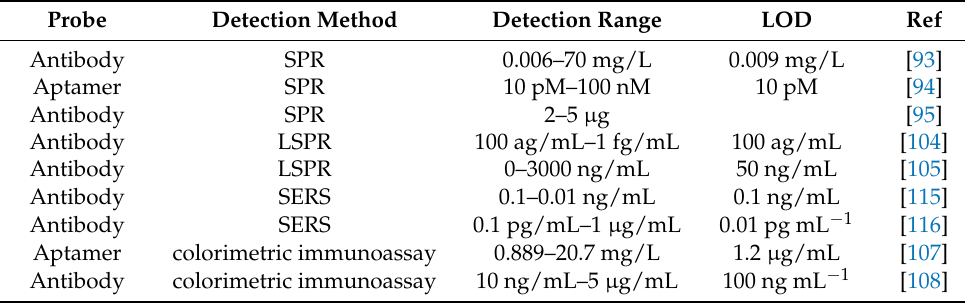
Table 3. Summary of surface plasmon resonance (SPR) biosensing